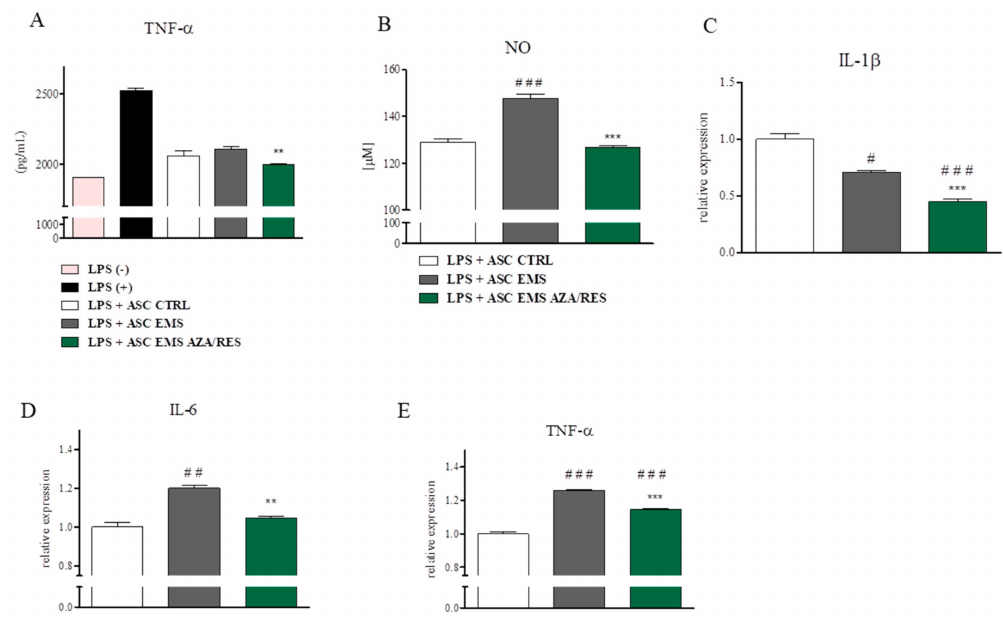
Figure 7. Anti-inflammatory properties of ASC s cultured with RAW 264.7 macrophages. ASCs were co-cultured with LPS-treated macrophages in order to evaluate their immunomodulatory properties. After co-culture culture media was collected and subjected for TNF- α ( A ) analysis with ELISA test. Using Griess reagent amount of NO was examined ( B ). RT-PCR was performed to investigate expression of IL-1 β ( C ), IL-6 ( D ), and TNF- α ( E ). Statistical significance was labelled with hash (#) when comparing to control group (LPS+ASC CTRL ) and asterisk (*) when comparing to EMS group (LPS+ASC EMS ).